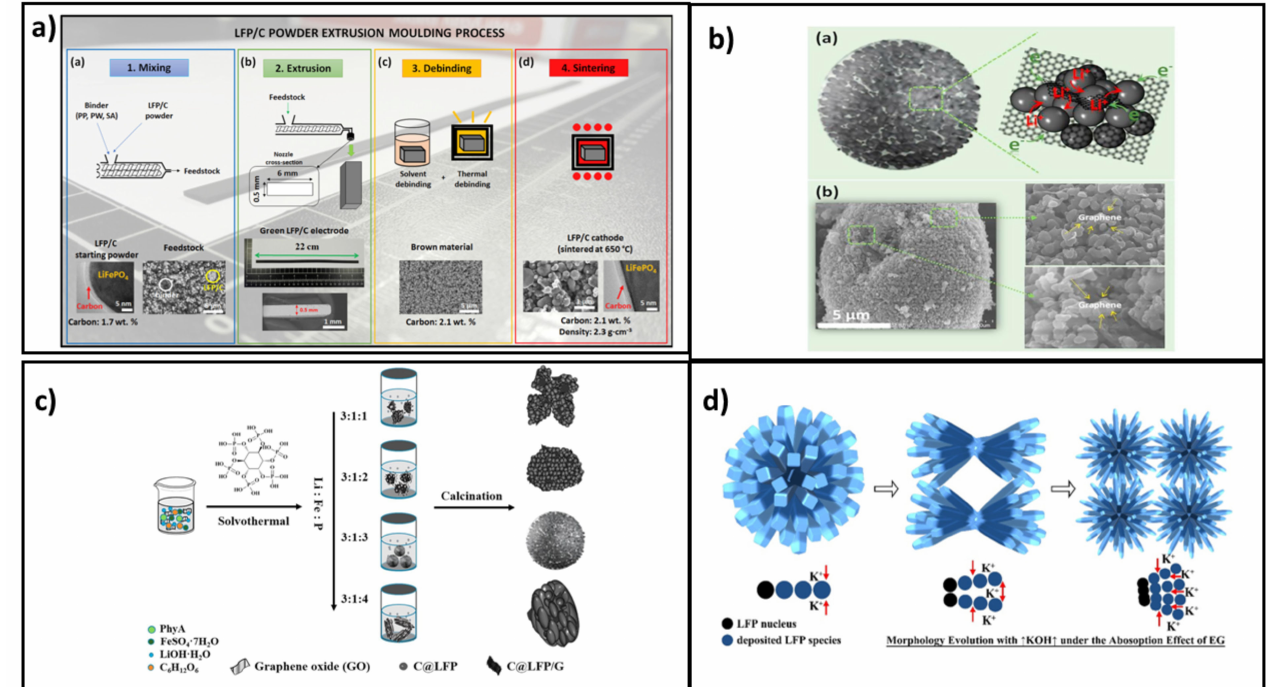
Figure 6. ( a ) Schematic representation of LFP preparation by powder extrusion modelling process (adapted with permission from Ref. [58]. 2020 Elsevier). ( b ) Illustration and SEM image of glucose, and graphene oxide in porous C@LFP/G microsphere (adapted with permission from Ref. [59]. 2018 Elsevier). ( c ) One pot solvothermal synthesis protocol of LFP/C composite (adapted with permission from Ref. [59]. 2018 Elsevier). ( d ) Morphology representation of LFP micro spindles and micro flowers (adapted with permission from Ref. [60]. 2019